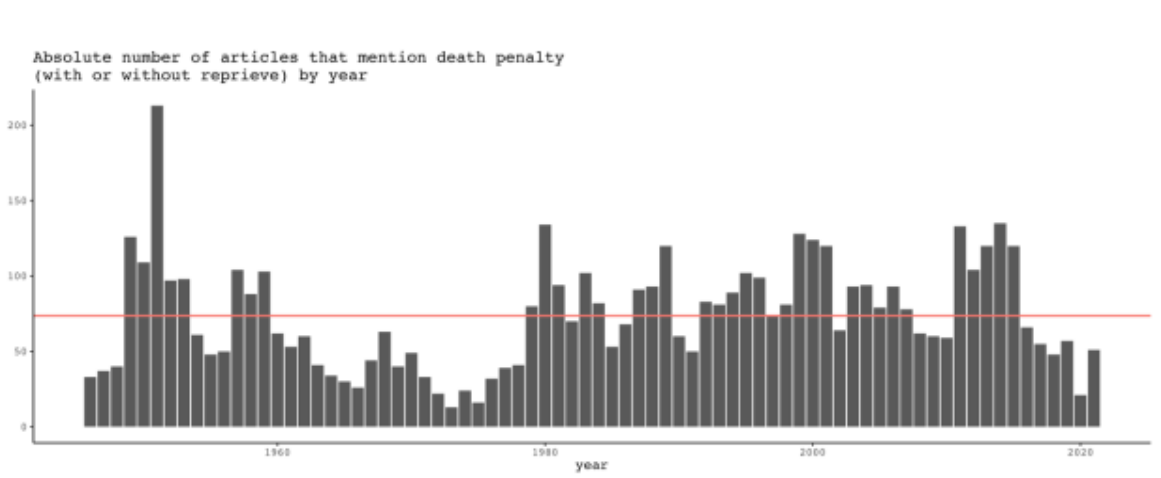
Figure 1. Number of articles in The People’s Daily that mention the death penalty (with or without reprieve) by year Source: The People’s